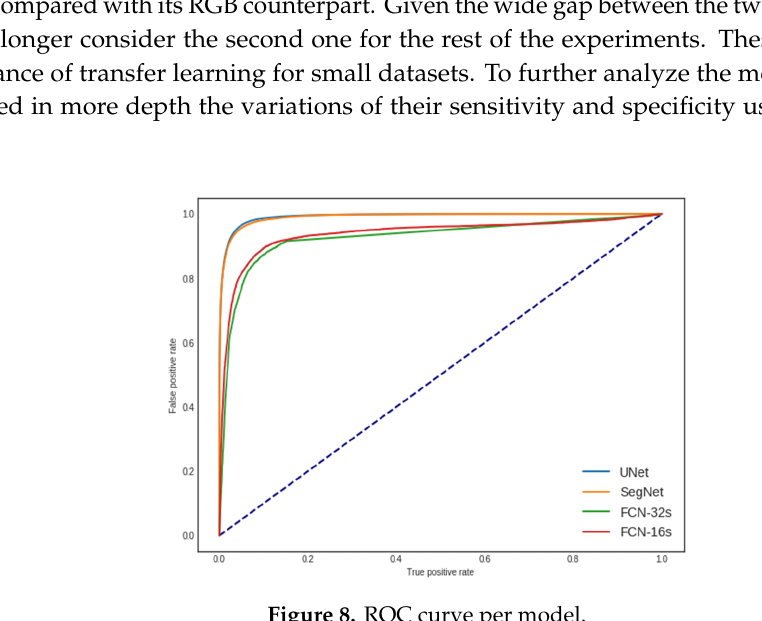
Figure 7. Learning curve per model.